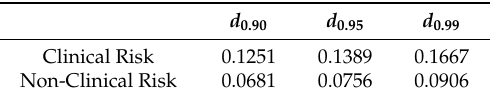
Table 4. Critical value test of severity of